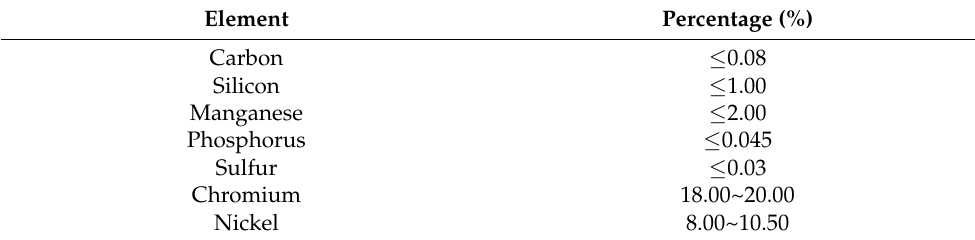
Table 2. Chemical composition of SUS304 [17,19–21].